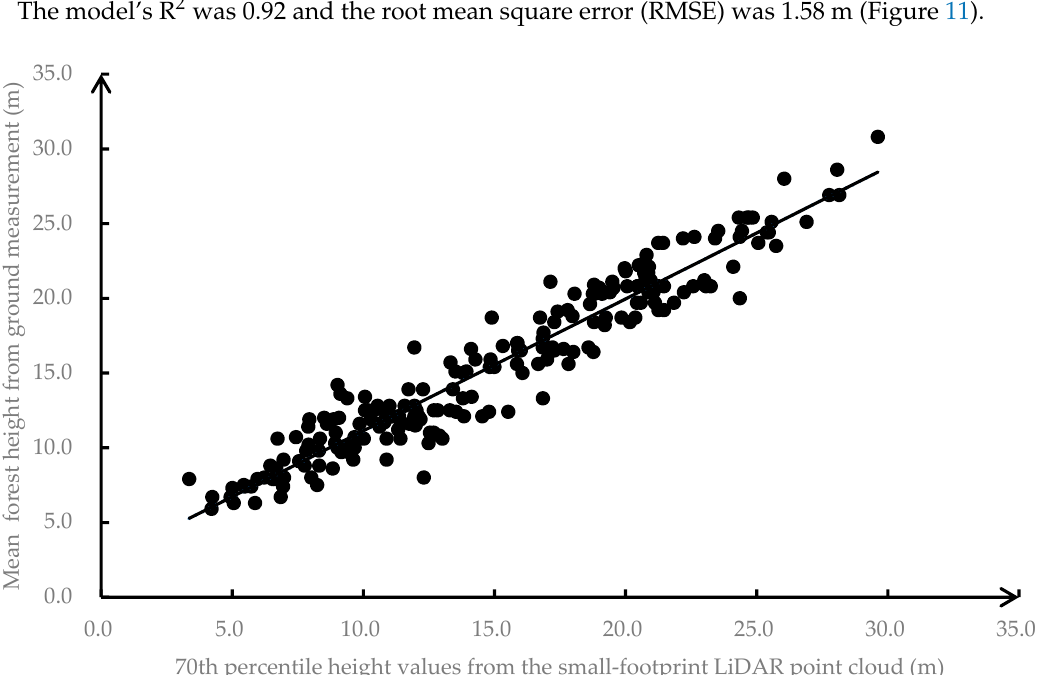
Figure 11. Relationship between 70th percentile small-footprint LiDAR height values and heights measured on sample plots ( n = 214). The dark line is the linear regression line from Equation (12).